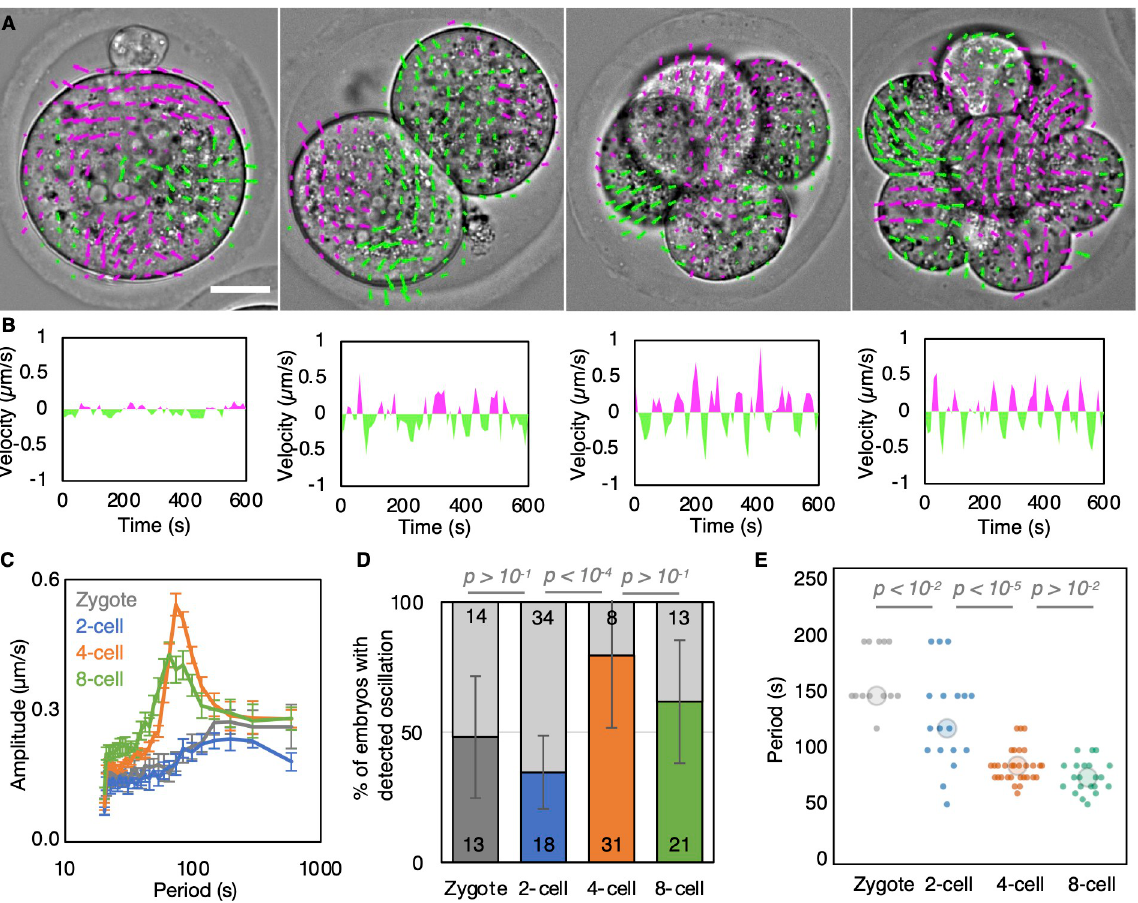
Fig 1. Analysis of PeCoWaCo during cleavage stages. (A) Representative images of a short-term time-lapse overlaid with a subset of velocity vectors from PIV analysis during cleavage stages (S1 Movie). Magenta for positive and green for negative Y directed movement. Scale bar, 20 μ m. (B) Velocity over time for a representative velocity vector of each embryo shown in A. (C) Mean power spectrum resulting from Fourier transform of PIV analysis of zygote (gray, n = 13), 2-cell (blue, n = 18), 4-cell (orange, n = 31), and 8-cell (green, n = 21) stages embryos showing detectable oscillations. Data show as mean ± SEM (S1 Table). (D) Proportion of zygote (gray, n = 27), 2-cell (blue, n = 52), 4-cell (orange, n = 39), and 8-cell stage (green, n = 34) embryos showing detectable oscillations after Fourier transform of PIV analysis. Light gray shows nonoscillating embryos. Error bars show SEM. Chi-squared p -values comparing different stages are indicated (S1 Table, S1 Data). (E) Oscillation period of zygote (gray, n = 13), 2-cell (blue, n = 18), 4-cell (orange, n = 31), and 8-cell (green, n = 21) stages embryos. Larger circles show median values. Student t test p -values are indicated (S1 Table, S1 Data). PeCoWaCo, periodic cortical waves of contraction; PIV, Particle Image